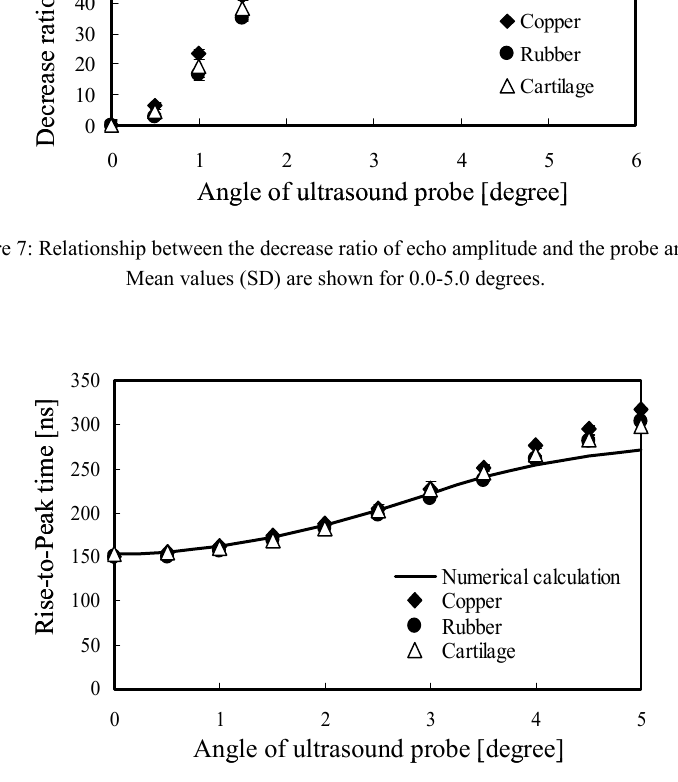
Figure 8: Relationship between Rise-to-Peak time and probe angle for the copper, rubber and articular cartilage surfaces. Mean values (SD) are shown for 0.0-5.0 degrees. The solid line shows Rise-to-Peak time of calculated waveforms using equation (3).